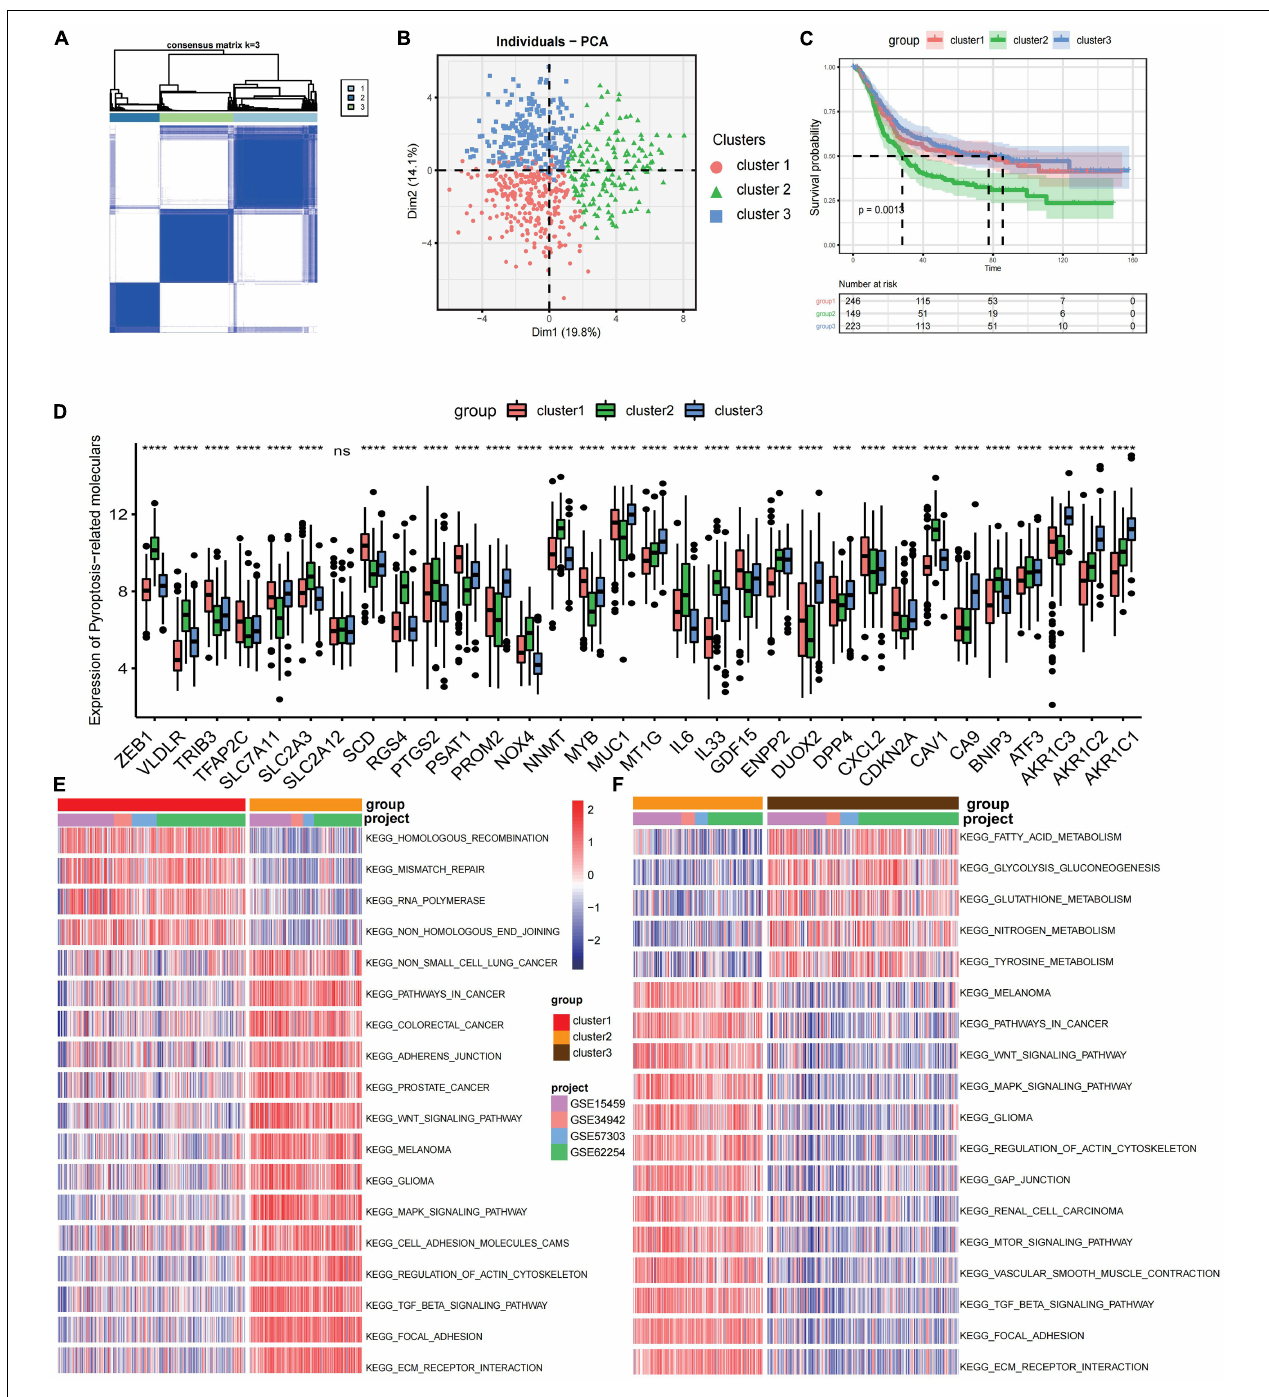
FIGURE 1 | Prognosis and biological characteristics of each ferroptosis-related subtype. (A) Consensus clustering matrix for k = 2. (B) Principal component analysis for the transcriptome profiles of three ferroptosis-related subtypes. (C) Kaplan–Meier analysis of patients in the three different ferroptosis-related subtypes. (D) Expression profiles of 32 ferroptosis-related genes in three subtypes. ns , no significance. *** p < 0.001; **** p < 0.0001, as determined by the Kruskal–Wallis test. (E,F) Enrichment degree of biological pathways in the different ferroptosis-related subtypes shown in a heatmap: cluster 1 vs. cluster 2 (E) and cluster 2 vs. cluster 3 (F)